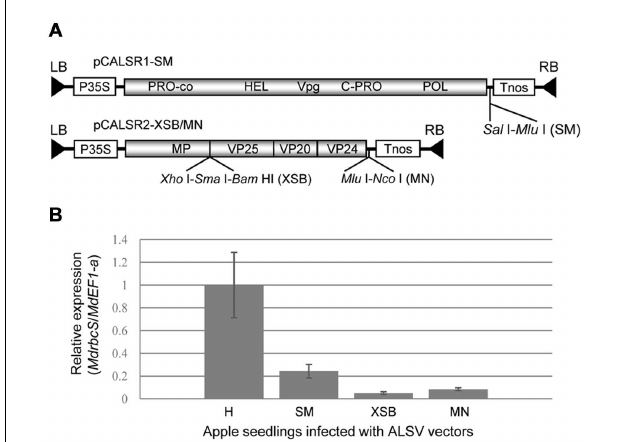
FIGURE 1 | Schematic representation of Apple latent spherical virus (ALSV) binary vectors and comparison of their capability to induce RNA silencing at their three cloning sites. (A) Genetic map of ALSV binary vector (pBCALR1-SM and pBCALR2-XSB/MN). LB and RB, left and right borders, respectively; P35S, CaMV 35S RNA promoter; NOS, nopaline synthase terminator. The open reading frames of ALSV represent the protease co-factor (Pro-co), NTP-binding helicase (HEL), cysteine protease (C-Pro), RNA polymerase (POL), movement protein (MP), and three capsid proteins (Vp25, Vp20, and Vp24). (B) Comparison of RNA silencing efficiency for the three cloning sites of ALSV vectors with a fragment of the MdrbcS gene inserted. The relative expression of MdrbcS -mRNA was estimated by quantitative